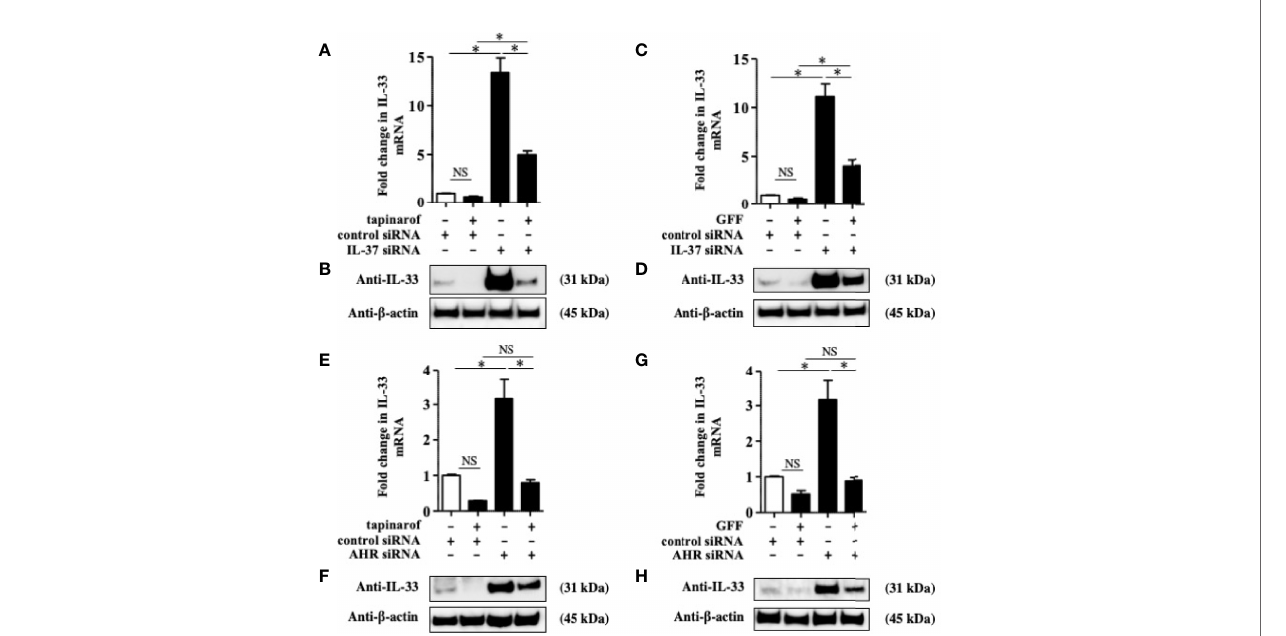
FIGURE 4 | Inhibitory effect of tapinarof and GFF treatment on IL-33 expression was partially dependent on the AHR/IL-37 axis in NHEKs. (A – H) NHEKs transfected with control siRNA, siRNA against IL-37 (IL-37 siRNA), or AHR siRNA were treated with either tapinarof (500 nM) or GFF (5%) for 48 h. (A, C, E, G) IL-33 expression was analyzed by qRT-PCR. Data are expressed as mean ± S.E.M.; n = 4 for each group. NS, not signi fi cant, *p < 0.05 (one-way ANOVA with Tukey ’ s multiple comparisons test). (B, D, F, H) IL-33 expression was analyzed by western blotting with an anti-IL-33 antibody. The data are representative of experiments repeated three times with similar